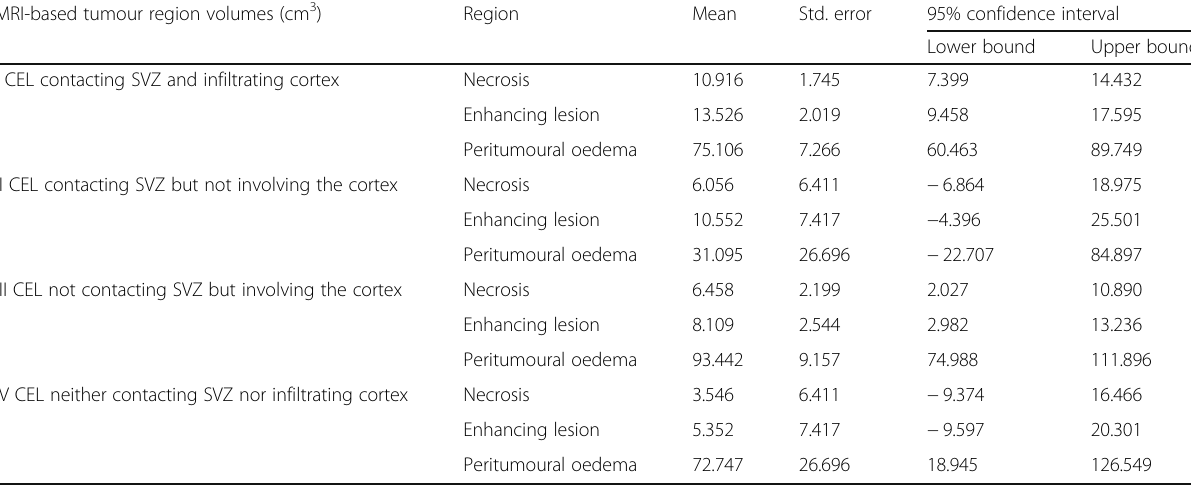
Table 4 Estimated marginal means volumes (cm 3 ) at each tumour regions and subgrouped based on SVZ and cortex involvement (MRI-based classification) MRI-based tumour region volumes (cm 3